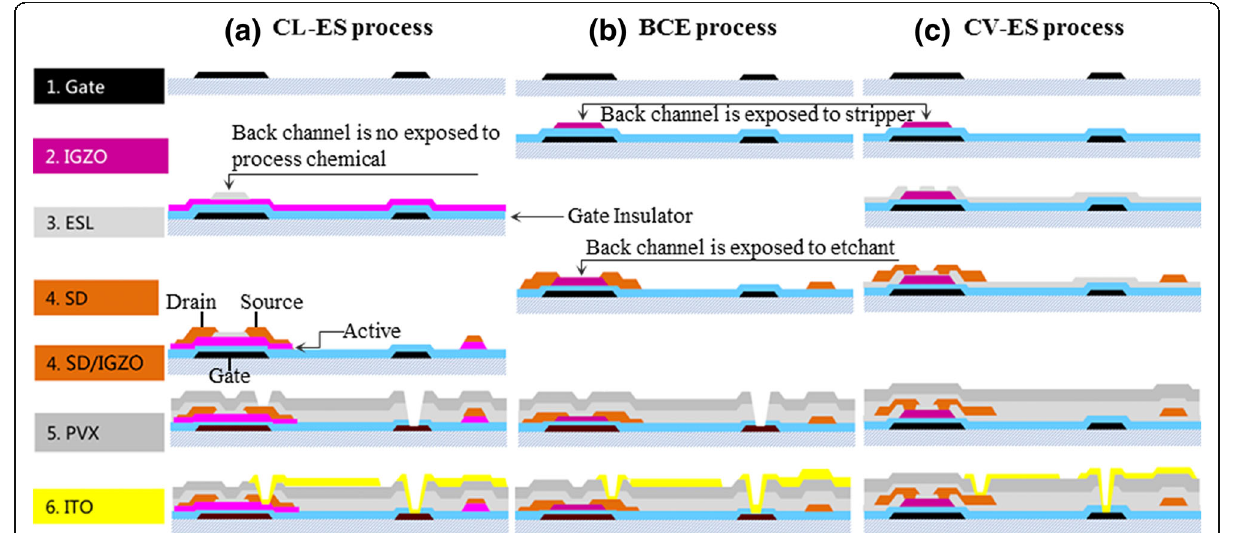
Fig. 1 (Color online) Schematics of a CL-ES, b BCE, and c CV-ES